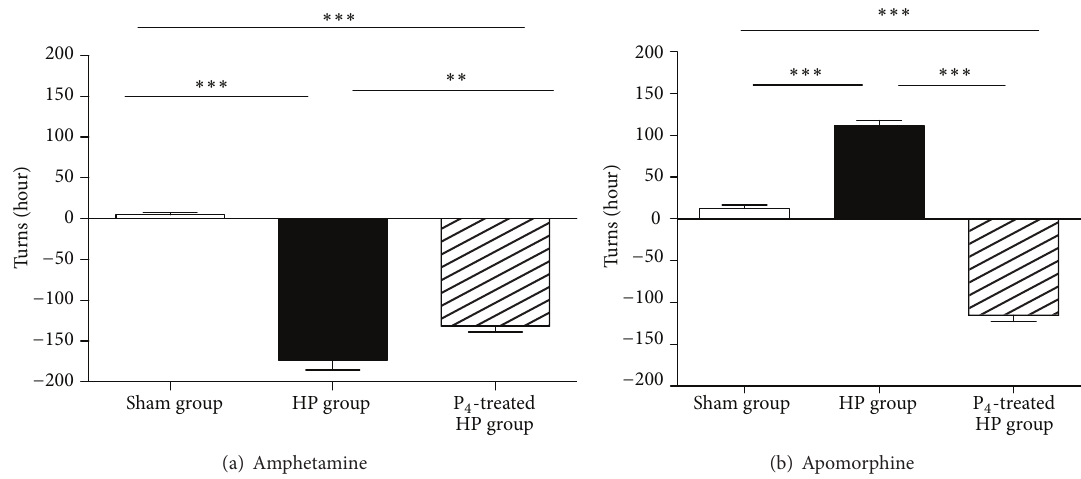
Figure 3: Effect of progesterone treatment on turning behavior induced by amphetamine (a) and apomorphine (b) at eight weeks after 6- OHDA lesion. Results are expressed as turns/hour (mean ± SEM); ∗∗ 𝑃 < 0.01 and ∗∗∗ 𝑃 < 0.001 (one-way